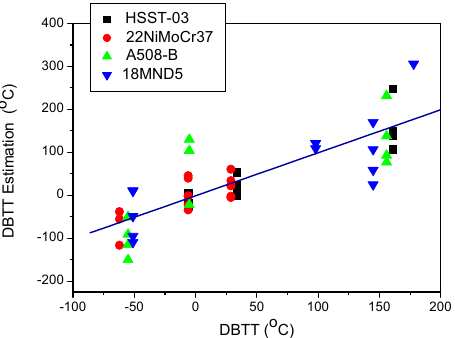
Figure 1. Estimated DBTT values as functions of the measured DBTT values for the investigated three base metals, 22NiMoCr37, A508-B, and HSST-03, and for one weld metal, 18MND5-W [11].